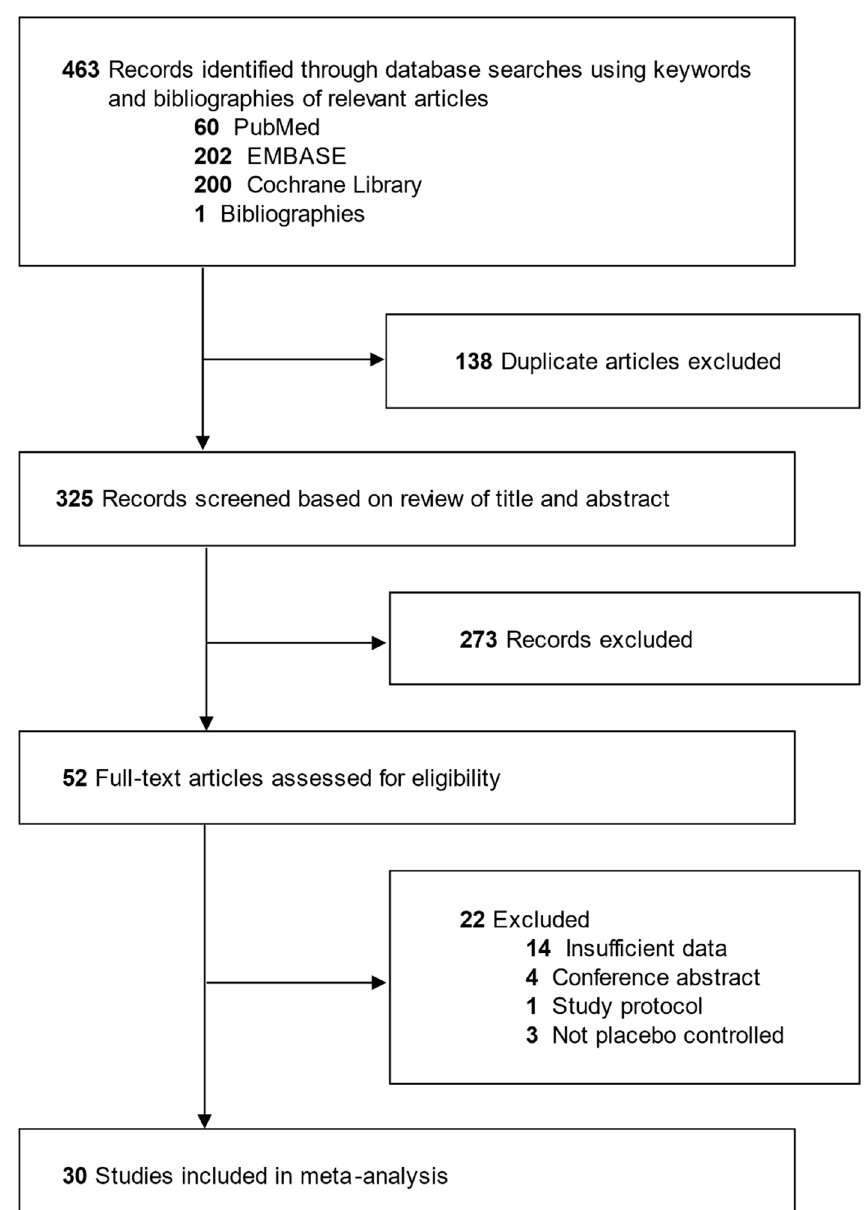
Figure 1. Diagram of the study selection process.